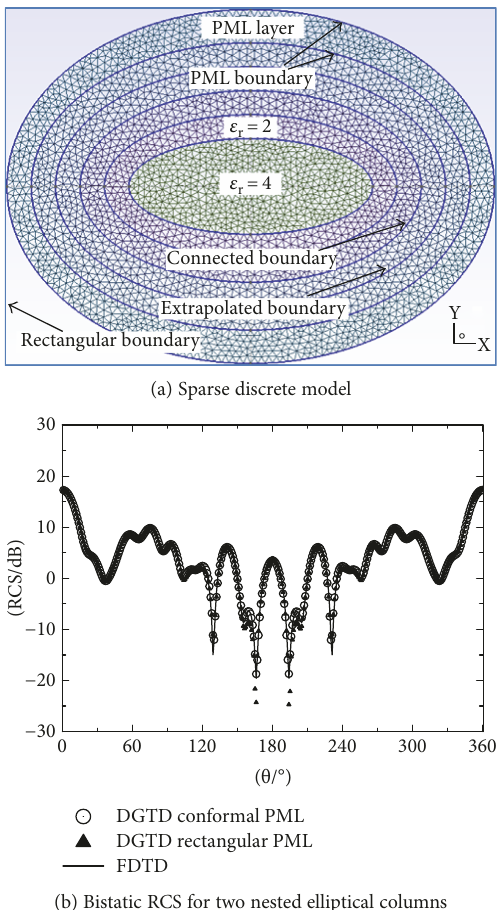
Figure 5: Bistatic scattering for